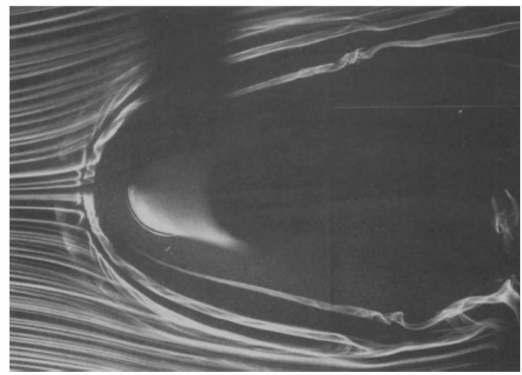
Figure 11. Plan view of horseshoe vortex around a cylinder